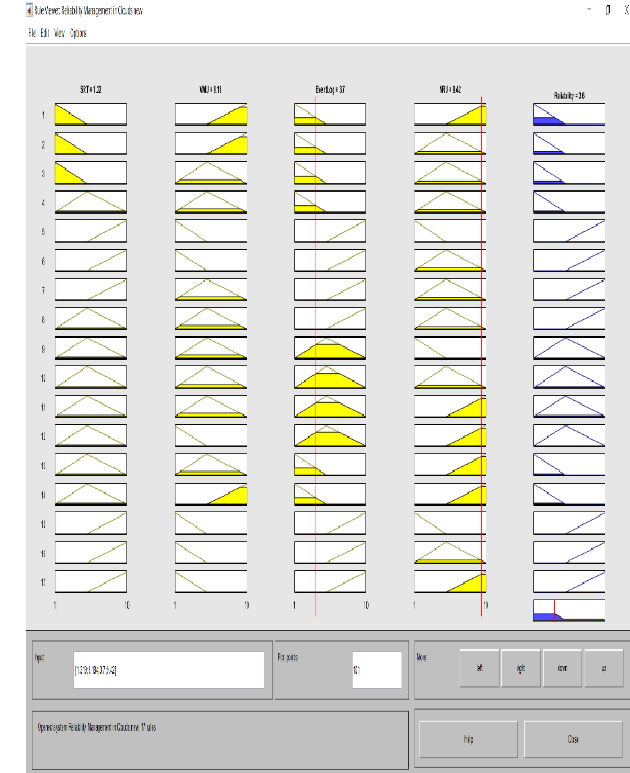
Figure 9. Lookup diagram for Medium